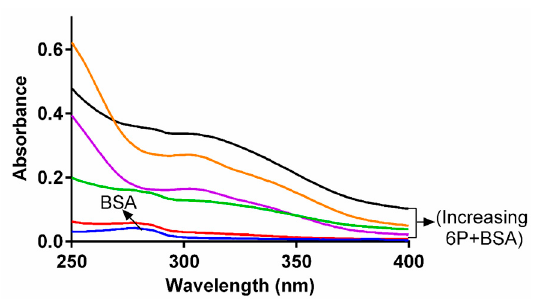
Figure 2. Spectra of BSA in presence and absence of 6P .